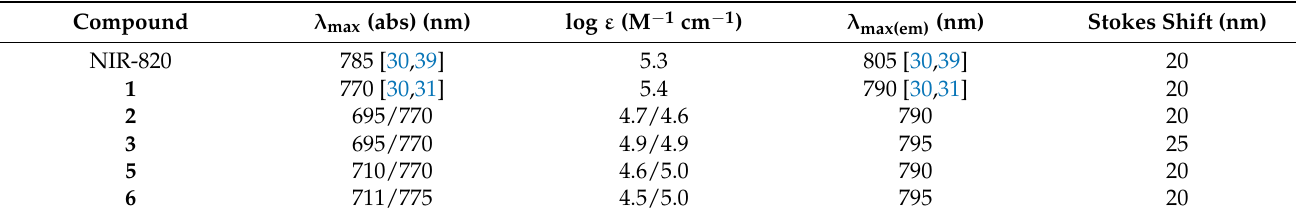
Table 1. Summary of the photophysical properties of the dyes NIR-820 and 1 , the MIUs 2 and 3 , and the bioconjugates 5 and 6 . All measurements were conducted in phosphate buffer solution and the excitation wavelength was λ ex = 650 nm.